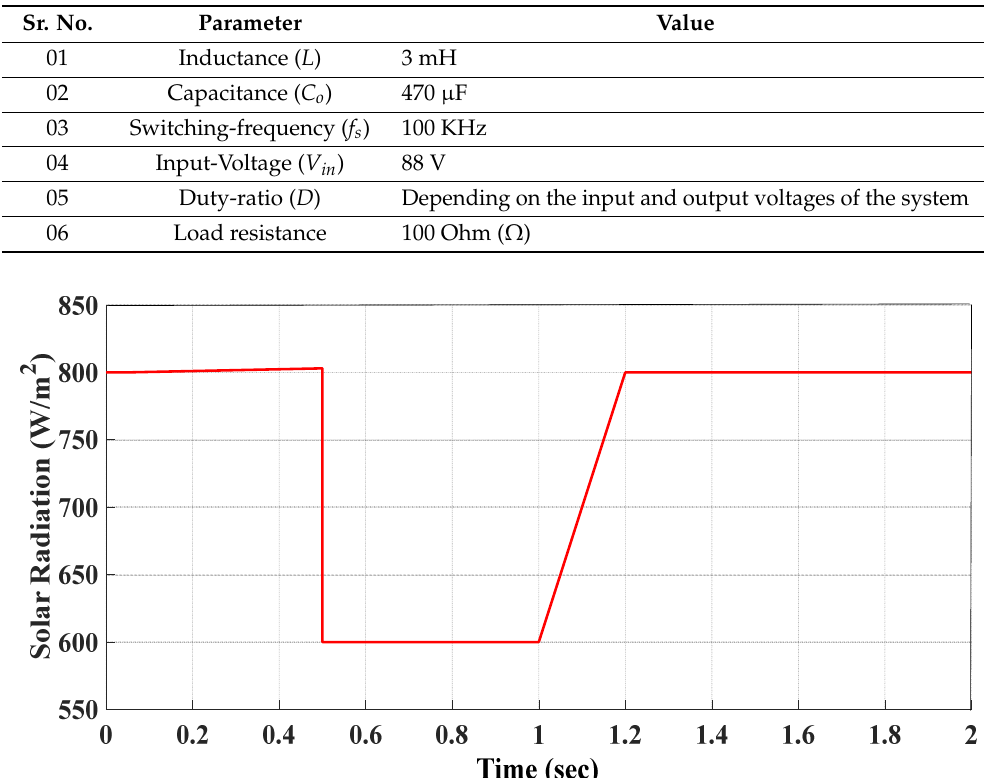
Table 2. Specification of Boost Converter.